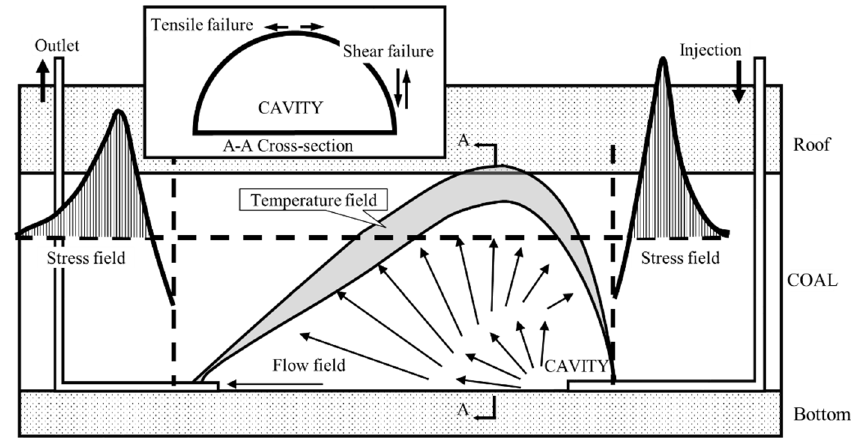
Figure 12. Multiple fields in a single cavity generation process.